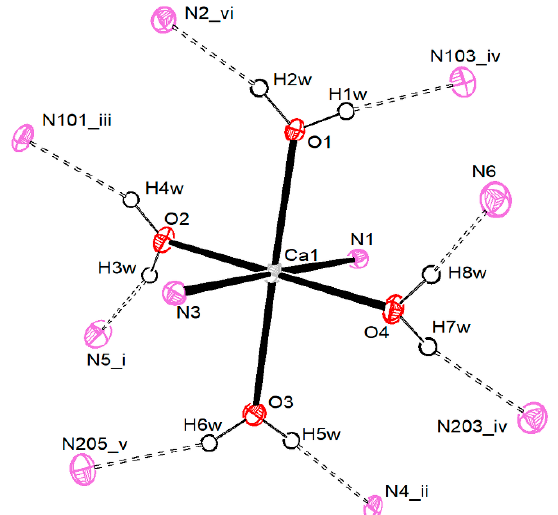
Figure 6 . The coordination sphere around Ca 2+ in compound 2 , with all the donated hydrogen bonds.